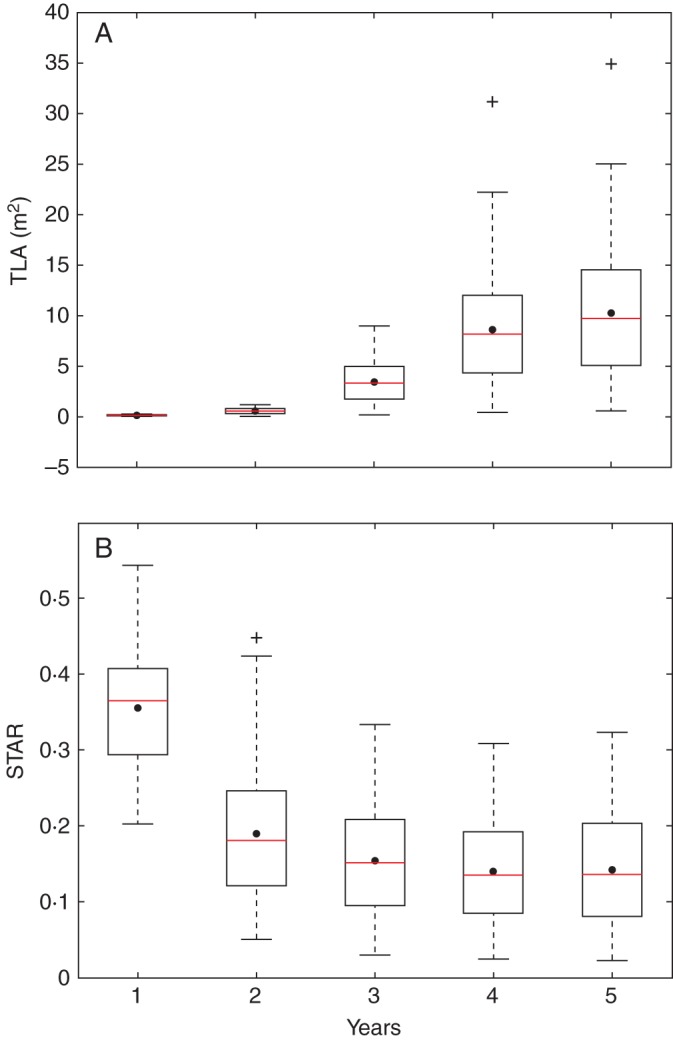
Evolution of TLA (total leaf area) and silhouette to total area ratio (STAR) for 300 simulated trees from the second to fifth year of growth in the geometry experiment, when varying four organ geometry parameters. Each box extends from the lower to upper quartile values, with a red line at the median and a dot at the mean values, respectively.